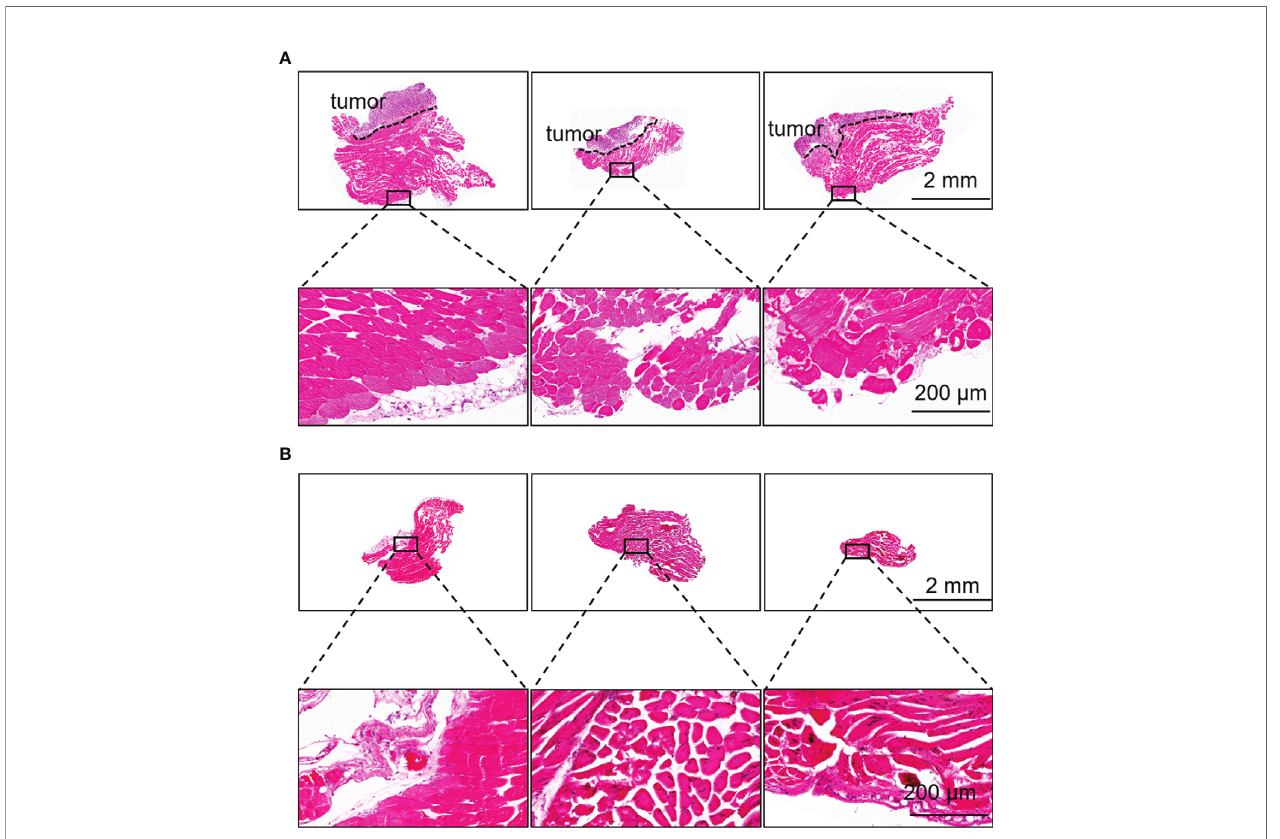
FIGURE 6 | Fluorescence-guided surgery based on HSA-ICG enabled complete removal of residual breast cancer lesions. (A) Representative hematoxylin and eosin staining of resected tissues that showed fl uorescence signal during surgery and a negative margin. Dashed lines demarcate the tumor. Rectangles indicate the location of the higher-magni fi cation views of the tissue margins, shown in the lower row. (B) Representative hematoxylin and eosin staining of the tissues on the surgical bed after surgery to con fi rm the absence of residual tumor.